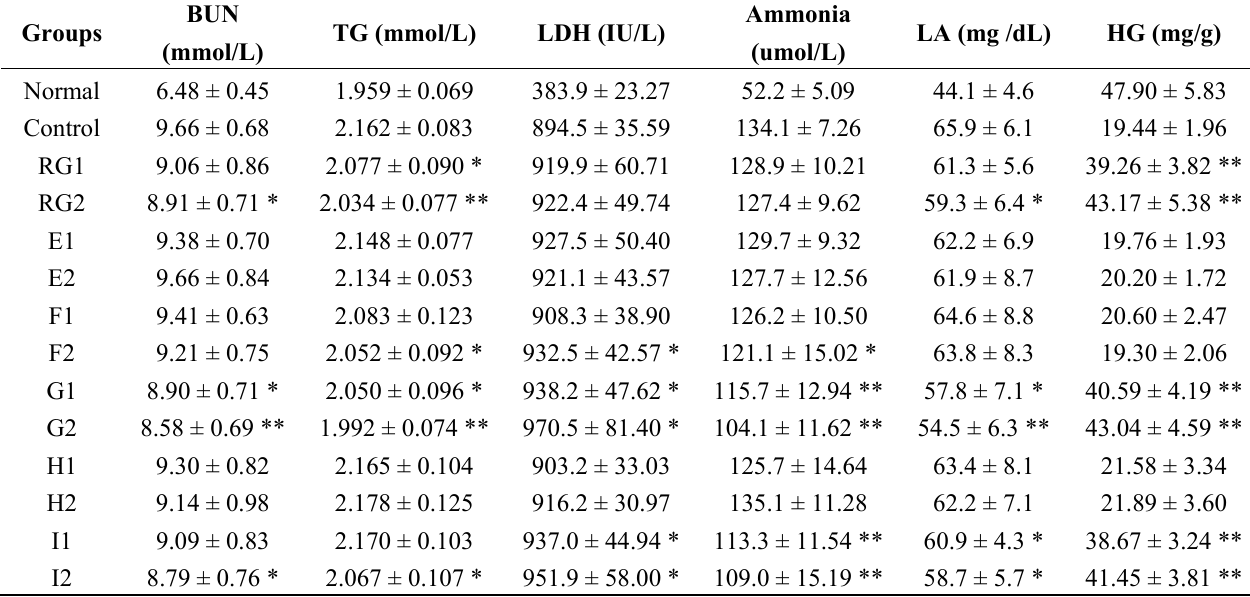
Table 4. The effects of the n -butanol and nigaichigoside F ammonia, LA and